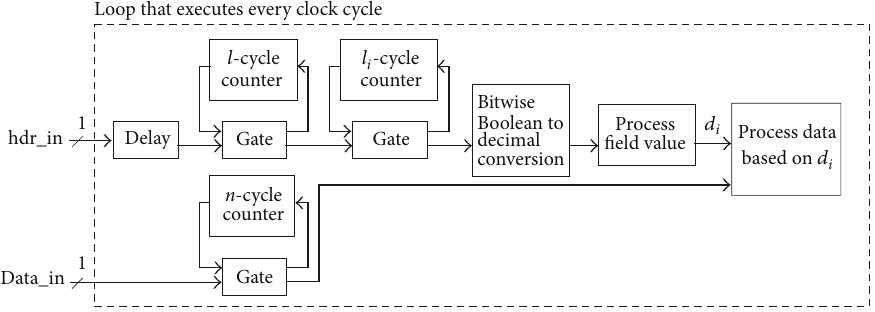
Figure 14: RTL block diagram: realization of an example of protocol-sensitive subsystem using HDL.